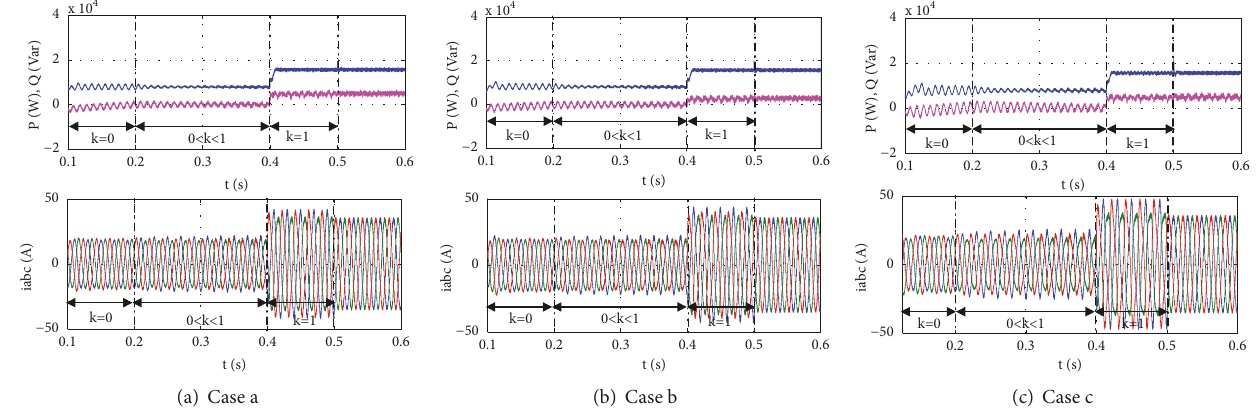
Figure 16: Dynamic response ability of active power and reactive power with step